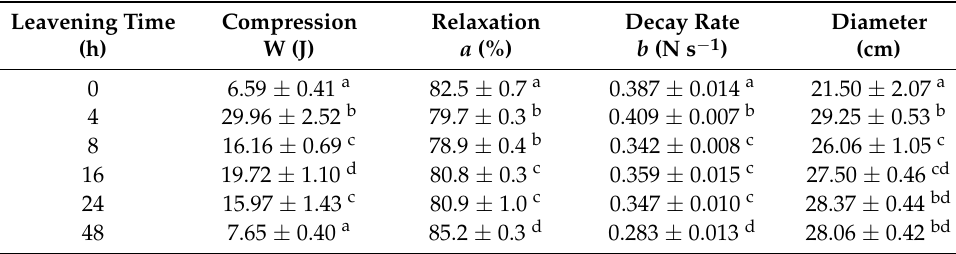
Table 1. Compression work (J), relaxation percentage ( a ), decay rate ( b ), and diameter reached by pizza dough after stress-relaxation test at selected leavening